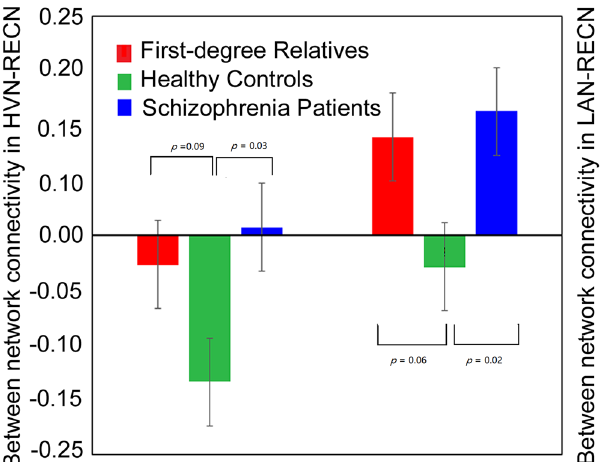
Figure 3. Bar plots for significant differences in intermodule connectivity between perception networks (high-visual and language) and right executive control network. RECN, right executive control network; LAN, language network; AUDN, auditory network; HVN, high-visual network; SZ, schizophrenia patients; FDR, first- degree relatives; HC, healthy controls. p value represent the uncorrected significant level of the comparison.